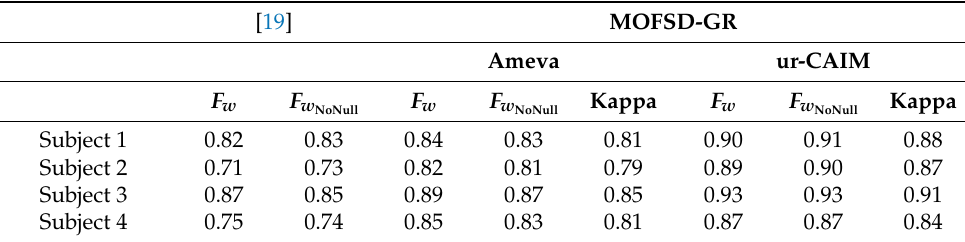
Table 2. Average recognition performances on the Opportunity dataset for the gesture recognition task, either with or without the null